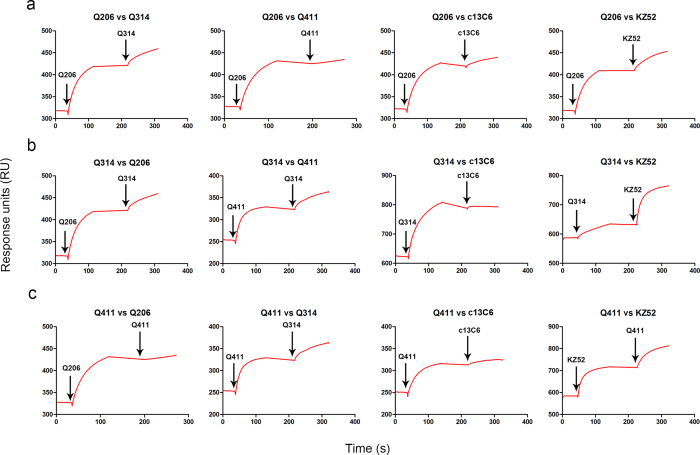
Epitope mapping through competitive binding measured by SPR.The sensorgrams show distinct binding patterns when pairs of testing Fabs were sequentially applied to the purified GPdM covalently immobilized onto a CM5 sensor chip. Arrows indicate the time points when Fabs were injected. Whether additional binding after injecting the second Fab is the key criteria for determining the two mAbs recognize the separate or closely situated epitopes.